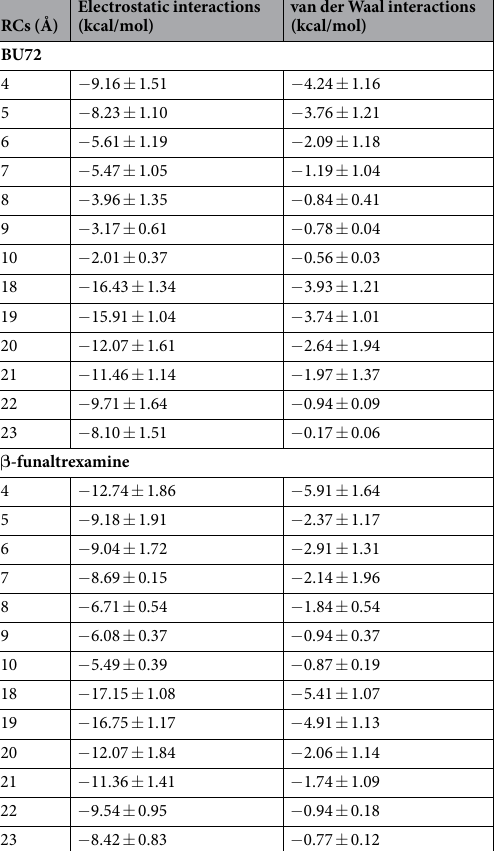
Table 2. Analysis of the electrostatic and van der Waals binding interactions (major barrier: at RCs of 4–12 Å; minor barrier: at RCs of 18–23 Å). * The electrostatic/van der Waals binding interactions between key residues (Table 1) and the two compounds were conducted for two barriers (at RCs of 4–10 and 18–23 Å).